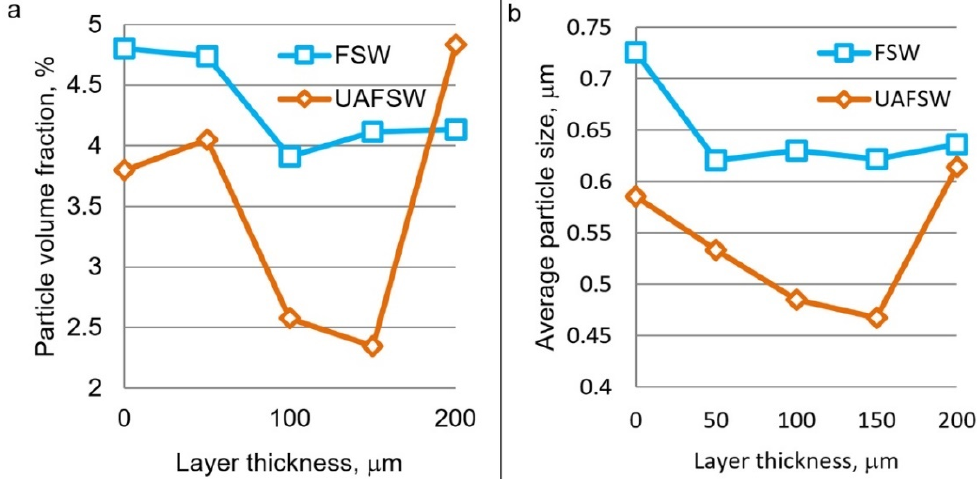
Figure 7. Results of measurement of the volume fraction ( a ) and average size ( b ) of secondary par ‐